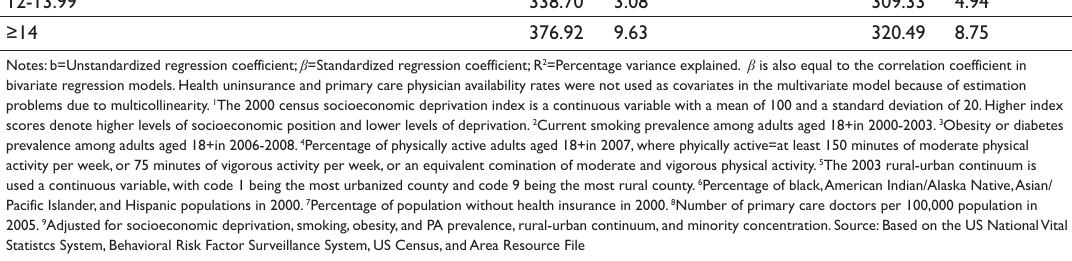
Age-adjusted CVD